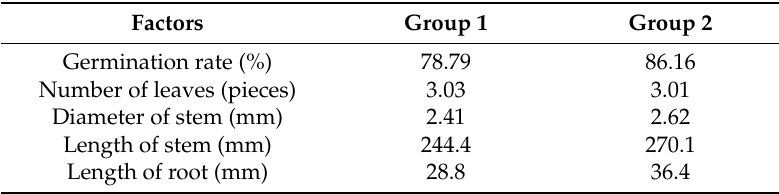
Figure 14. Factors for growth status. Table 13. The onion seedling growth states for both groups. Factors